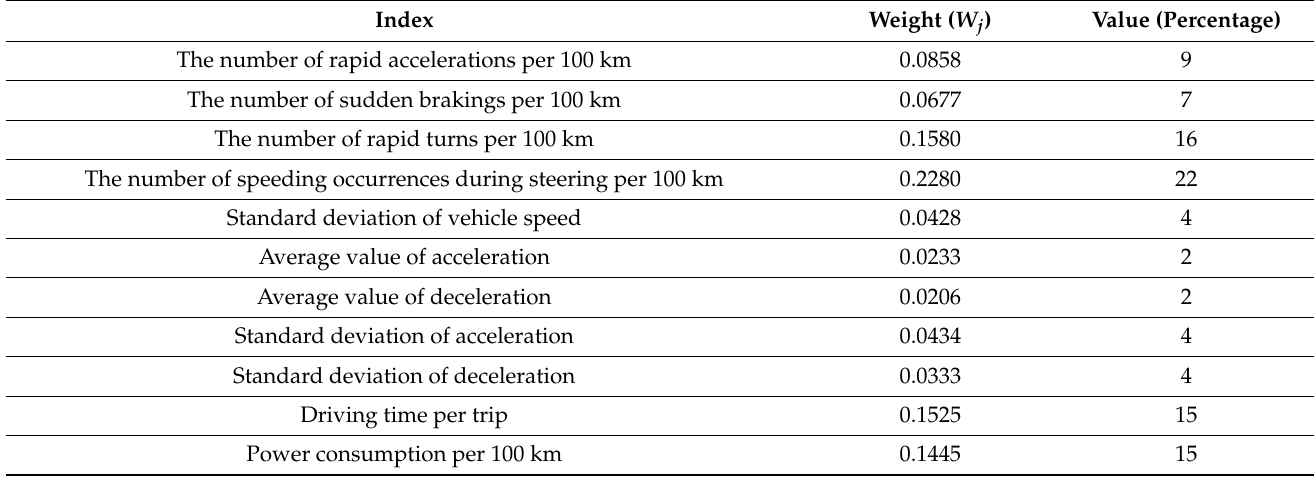
Table 8. The final weight for different